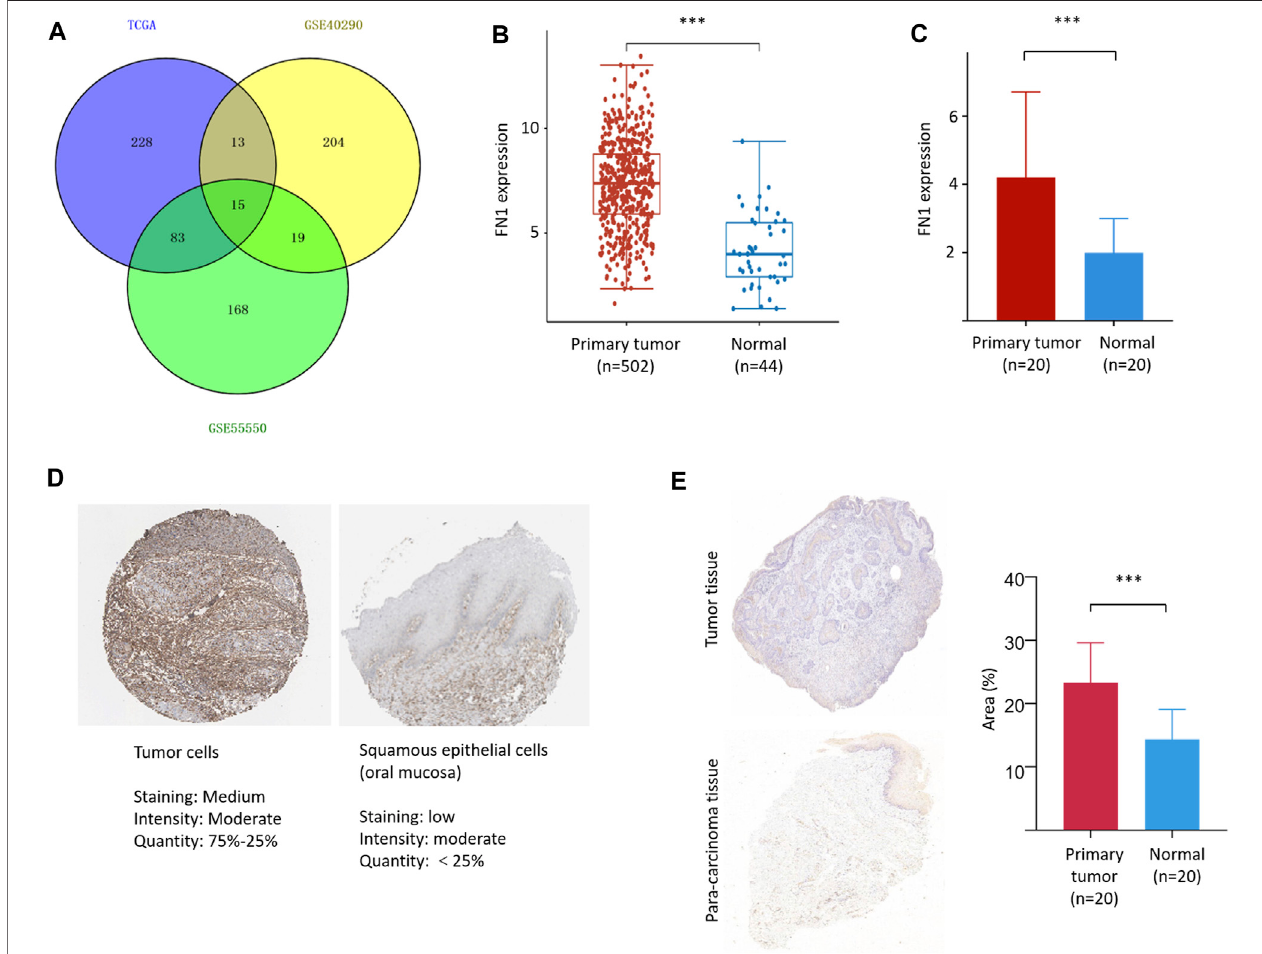
FIGURE1| FN1 fi lteringand its expression inHNSCC. (A) Atotalof15three-crossingand 115two-crossingDEGswere fi ltered among threepublic datasets.The mRNA level of FN1 was signi fi cantly higher in HNSCCs than in the normal para-carcinoma tissues from TCGA database (B) and our patients (C) . (D) The protein level of FN1 was much higher in HNSCC (left) than in the normal tissues of oral mucosa (right) , both from THPA. (E) Representative pictures of FN1 expression between different groups examined by IHC were shown (left) and veri fi ed by density value (right) and our patients.